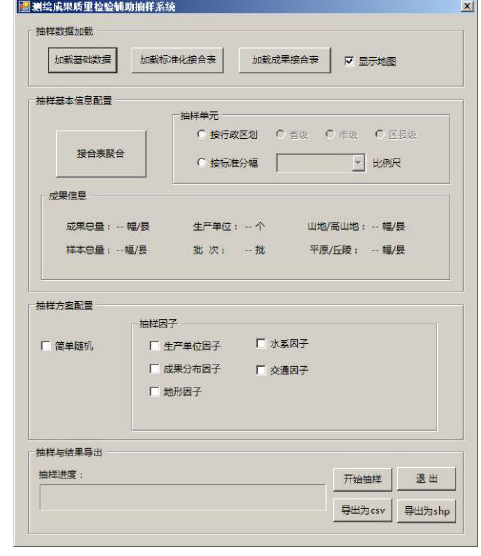
Figure 3. Software